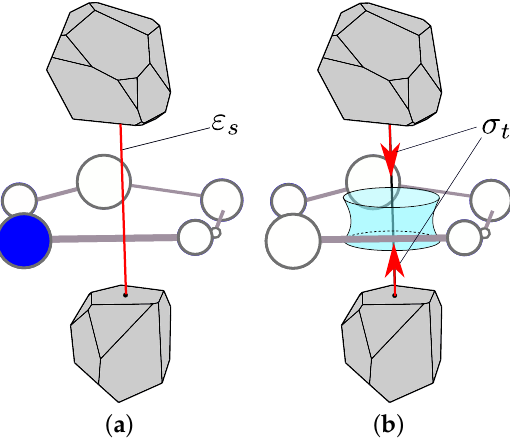
Figure 4. Coupling between the structural and transport network: ( a ) swelling strain is present if one of the spheres at mid-cross-section is water filled, and ( b ) the meniscus generates extra forces acting on the grain interaction if all spheres at the mid-cross-section are